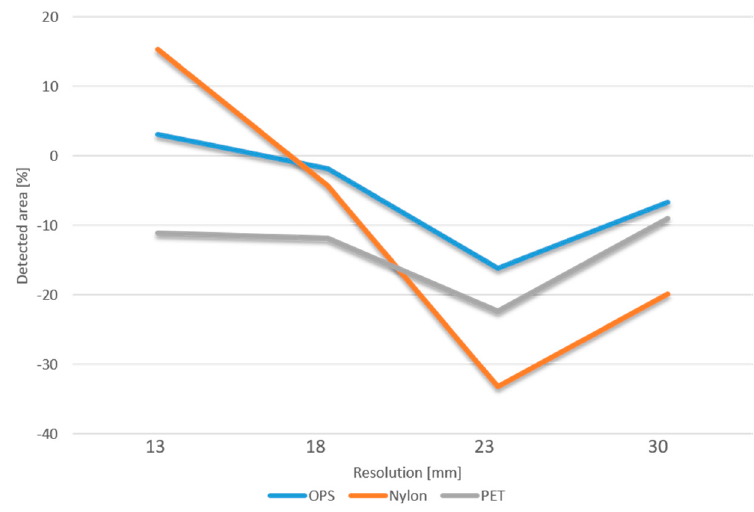
Figure 8. Differences in the extension of the detected area covered by plastic (using the classification of the 4 mm orthophoto as a reference value).